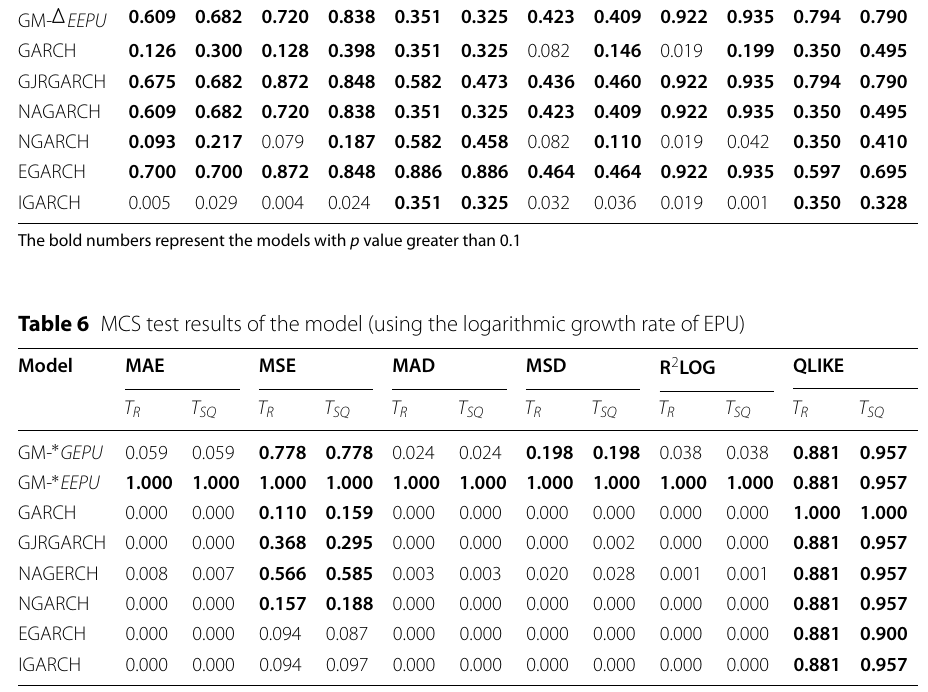
The bold numbers represent the models with p value greater than